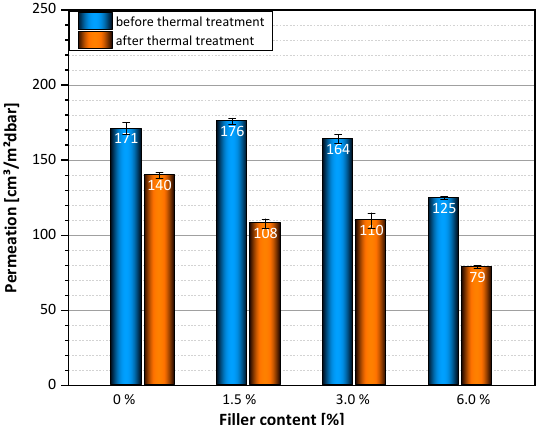
Figure 10. Permeation rates of films with different filler content compression-molded at 240 °C and 270 °C.